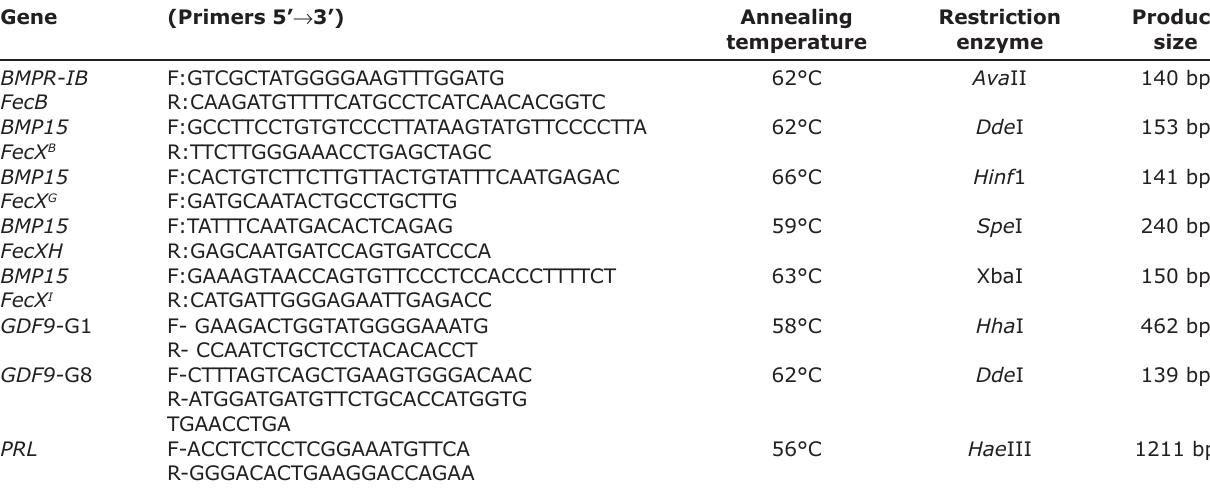
Table-1: Primer sequences, annealing temperatures, and PCR product sizes of the targeted genes conducted under this study. Gene (Primers 5’ →